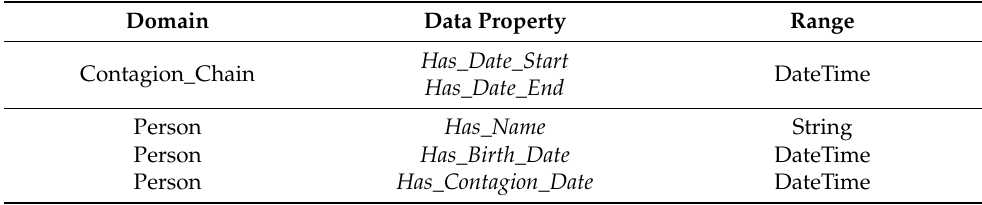
Table 2. Data properties of the classes Person and Contagion_Chain.